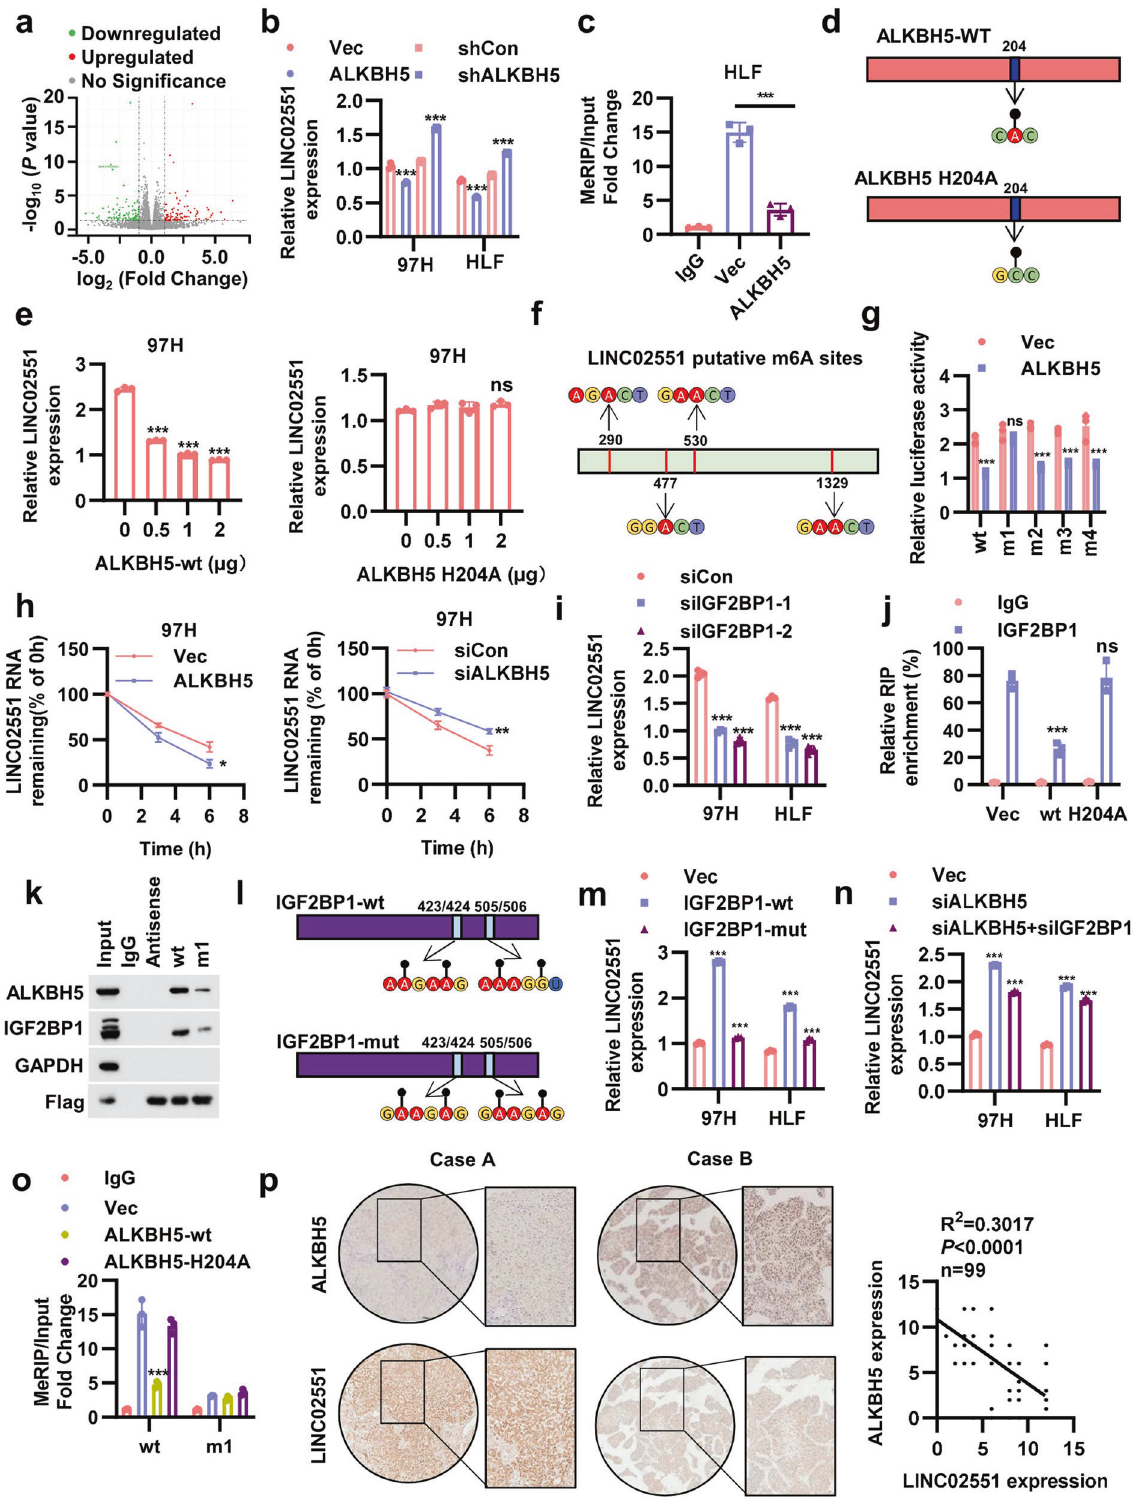
more lesions were observed in the mice injected with the LINC02551 overexpressing cells than in those injected with the control cells (Fig. 3g). These results suggested that LINC02551 promoted the progres- sion of HCC in